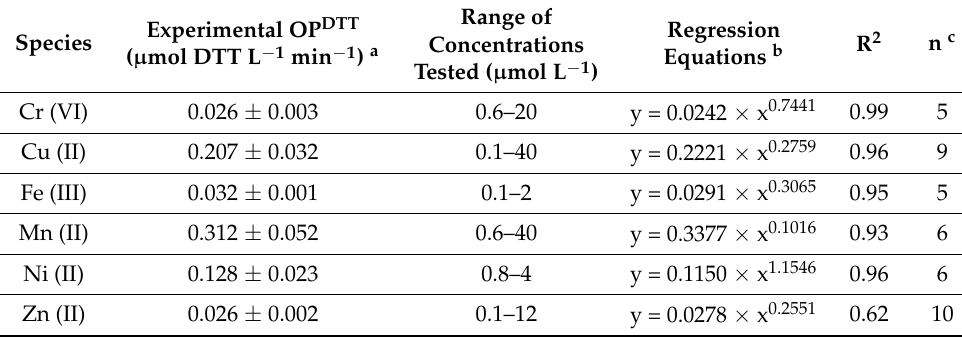
Table 2. Experimental metal oxidative potential (OP DTT ) at 1 µ mol L − 1 and regression equations for the dithiothreitol (DTT) loss rate depending on the concentration of individual metal ions. Range of Regression Experimental OP DTT Species R 2 n Concentrations Equations b ( µ mol DTT L − 1 min − 1 ) a Tested ( µ mol L − 1 )